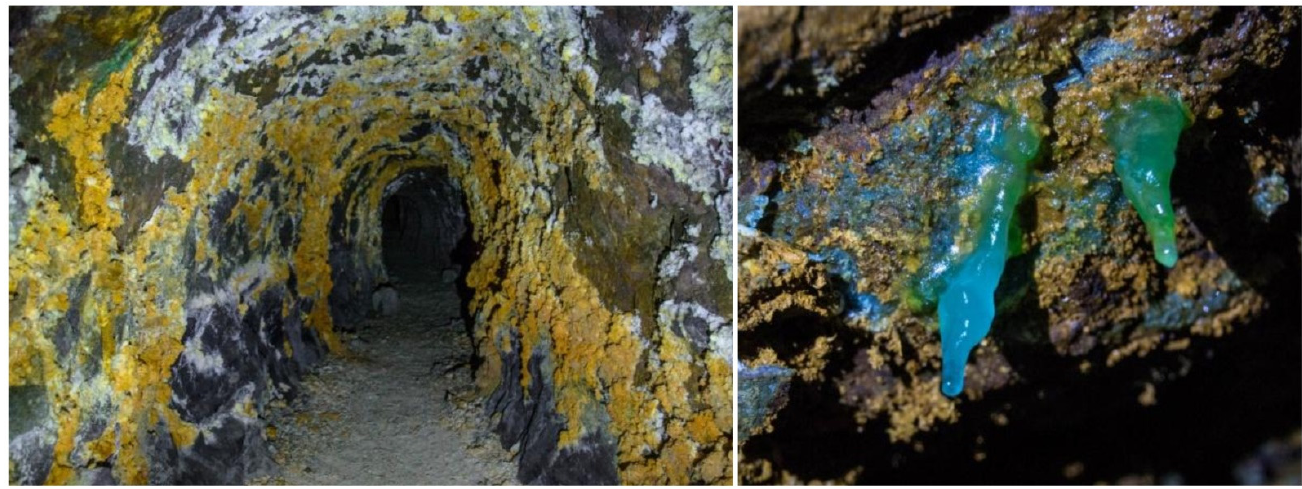
Figure 6. Alunogenka tunnel ( left ) and melanterite ( right ) (photo by Silvia Palgutov á